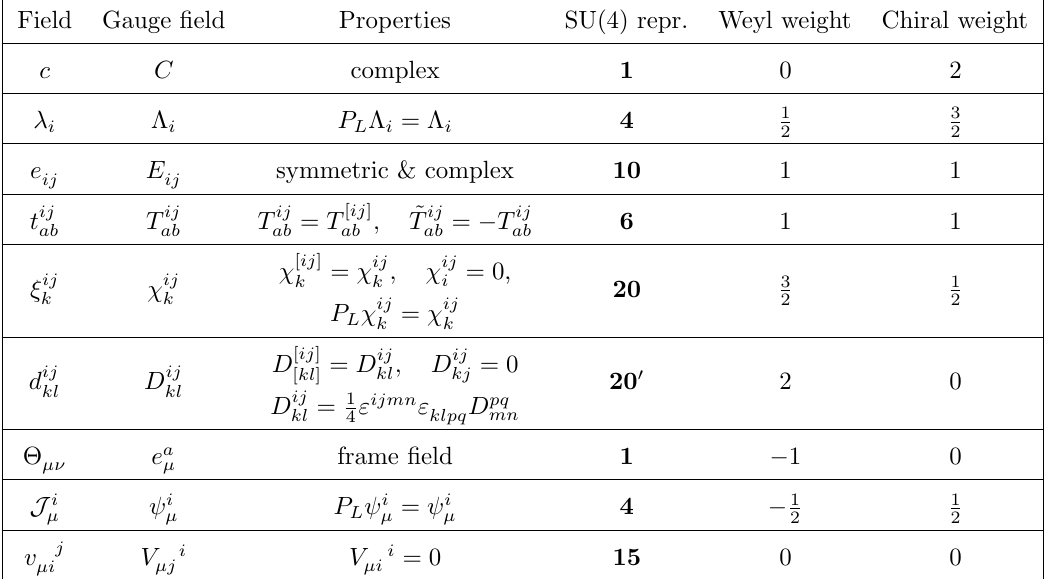
Table 2 . The multiplet of currents and their corresponding gauge/matter (cid:12)elds for N = 4 conformal supergravity. The third column shows some properties of the gauge (cid:12)elds derived from the properties of the currents, the fourth column gives the representation of the (cid:12)elds with respect to the R - symmetry group SU(4), and the (cid:12)fth and sixth column respectively give the Weyl and chiral weights of the gauge/matter (cid:12)elds. Explanations for the chiral weights are given at the end of section 2.2.